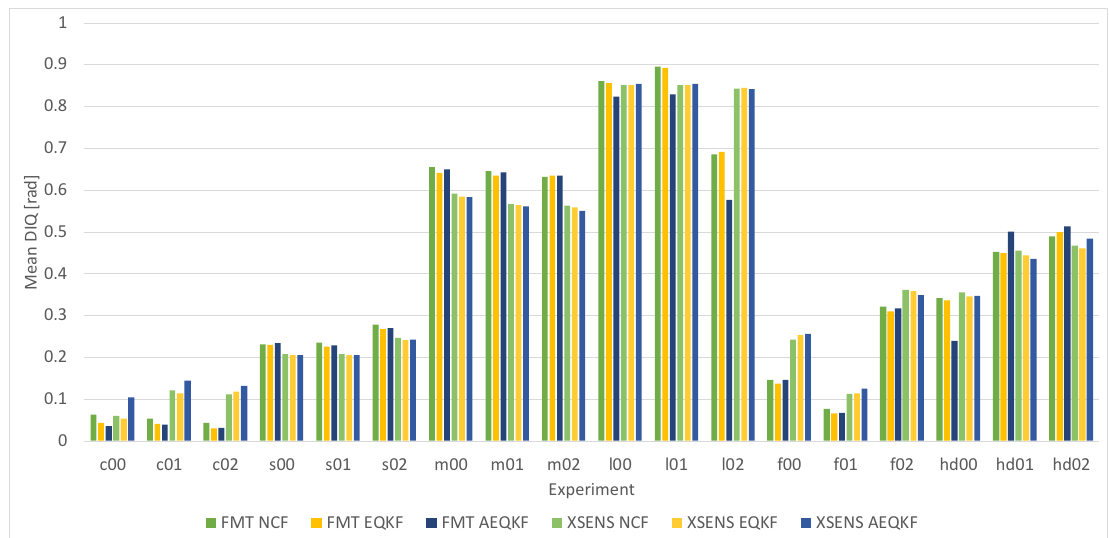
Figure 9. The mean deviation index DI Q for experiments (details in Table